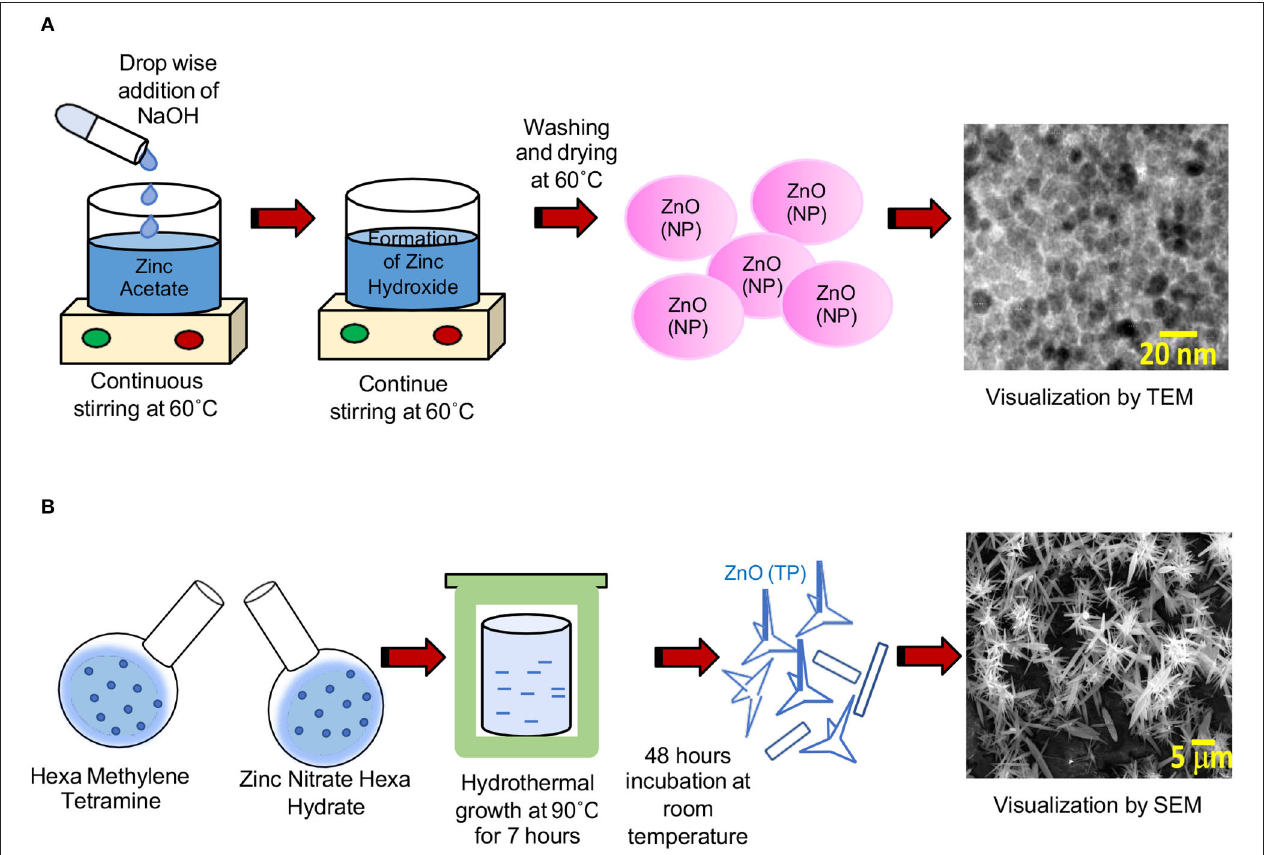
FIGURE 1 | Electron micrograph of ZnO(NP) and ZnO(TP). (A) TEM image of ZnO(NP). Scale bar: 20nm. (B) SEM image of ZnO(TP). Scale bar: 5 µ